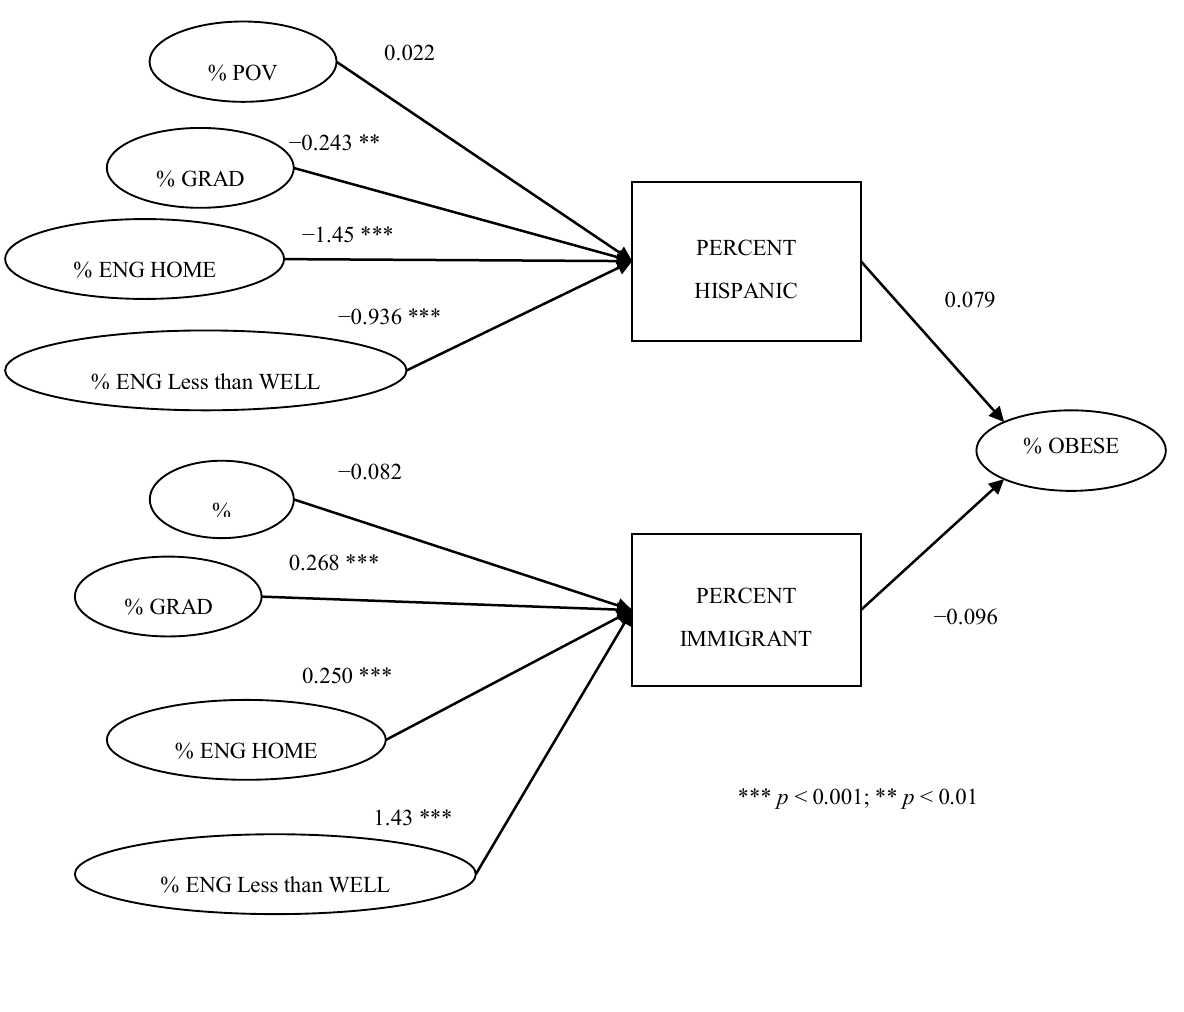
Figure 2. Path analysis for county-level obesity, % Hispanic, % immigrant and potential explanatory